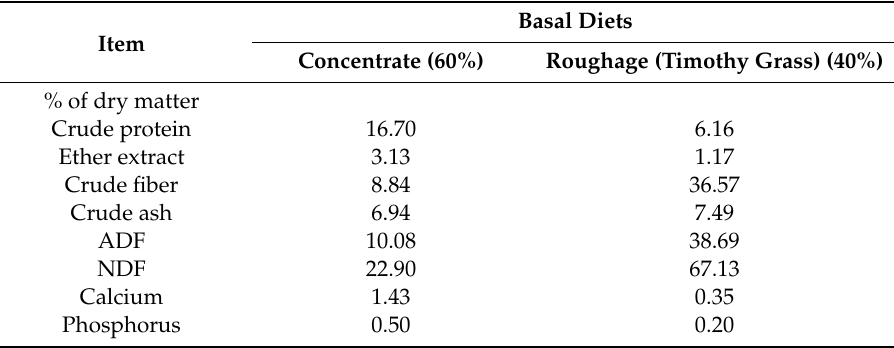
Table 1. Chemical composition of diets provided to the beef